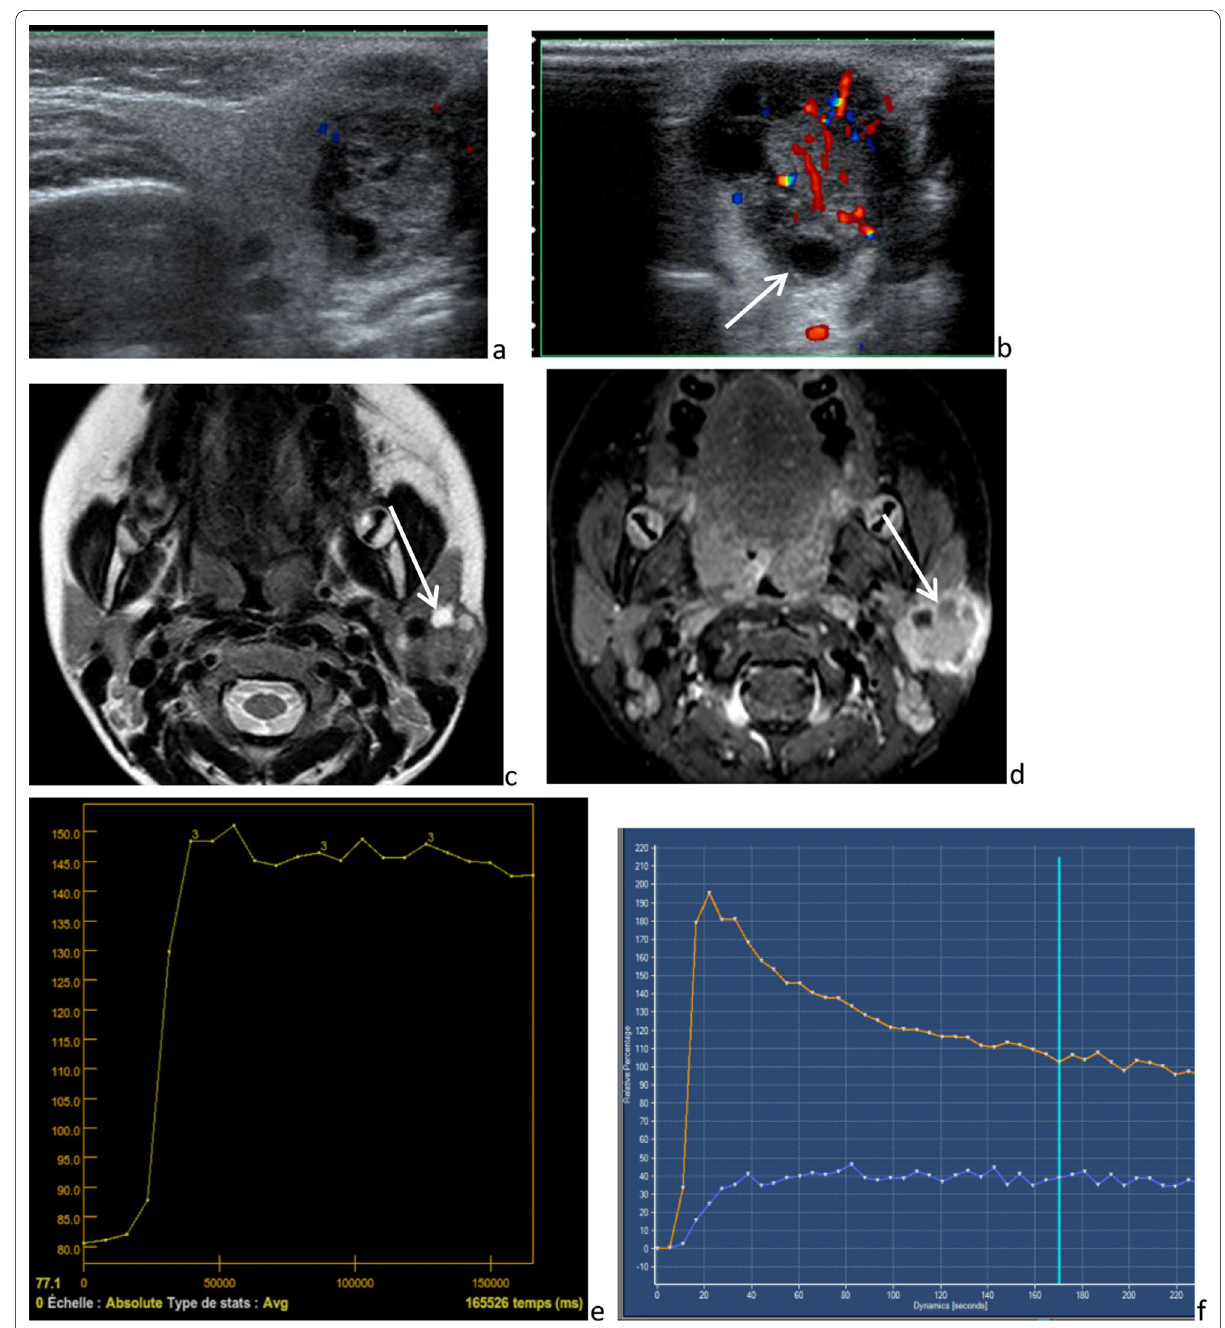
Fig. 17 Intermediate‑grade mucoepidermoid carcinoma: poorly delineated, heterogeneous tumor containing small necrotic areas [white arrow] and strongly enhanced, on ultrasonography ( a and b ), axial T 2 ‑weighted image ( c ) and T 1 ‑weighted image, after intravenous injection of gadolinium chelate ( d ). Time intensity curve with a signal growing rapidly in the first phase and a low wash out (< 30%): type C or plateau pattern (according to Yabuuchi), suggestive of malignancy ( e ). Conversely, time intensity curve of type B (orange line), with a high wash out (> 30%), in a case of parotid benign lymphadenopathy ( f